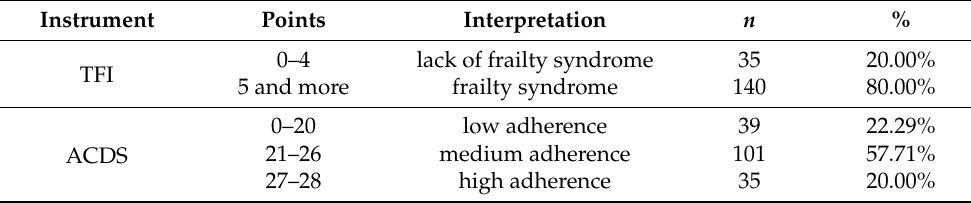
Table 2. Frailty syndrome occurrence and level of adherence to medication.